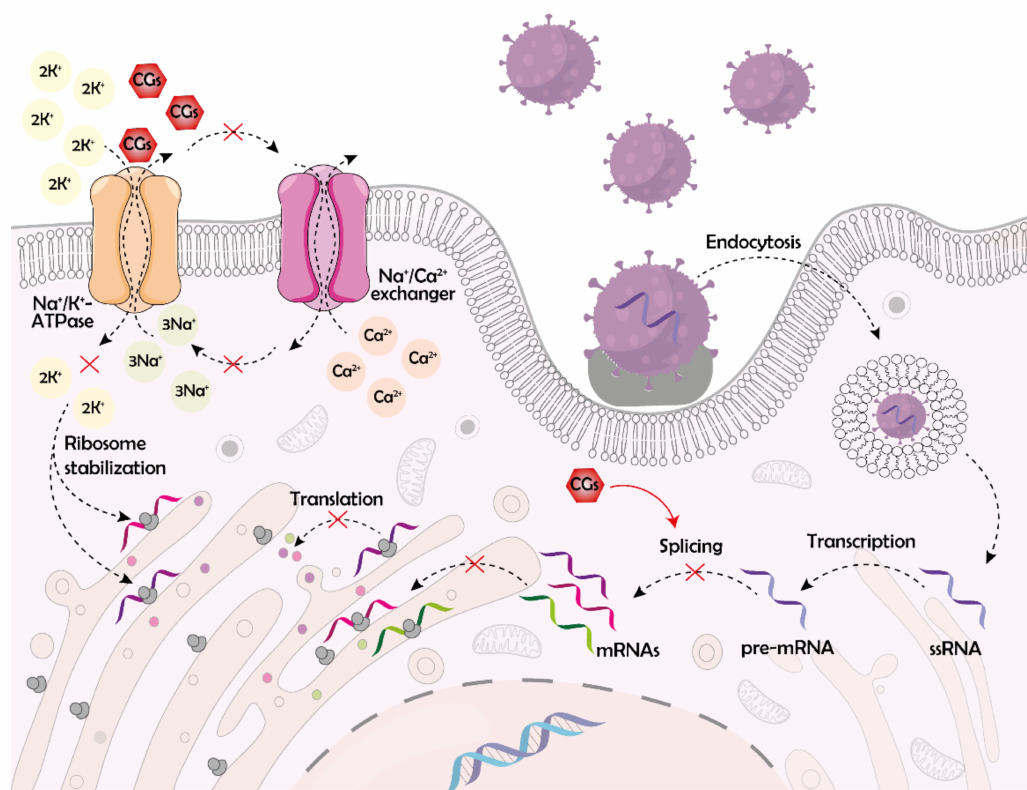
Figure 4. The effect of cardiac glycosides (CGs) on viral RNA synthesis and processing, and protein translation. CGs block RNA splicing by further unexplained mechanisms, which are likely linked to the Na + /K + -ATPase (NKA) signaling function (not indicated in the scheme). The result of this is a decreased pool of viral messenger ribonucleic acids (mRNAs) and a subsequent block of viral protein synthesis. The translation of viral proteins is hampered also by blocking the pumping function of NKA. As a consequence of this, the intracellular level of K + ions is decreased, which negatively affects ribosomal function. K + ions play a physiologically important role in the stabilization of the ribosomal complex. The improper function of ribosomes caused by K + depletion leads to decreased translation of viral